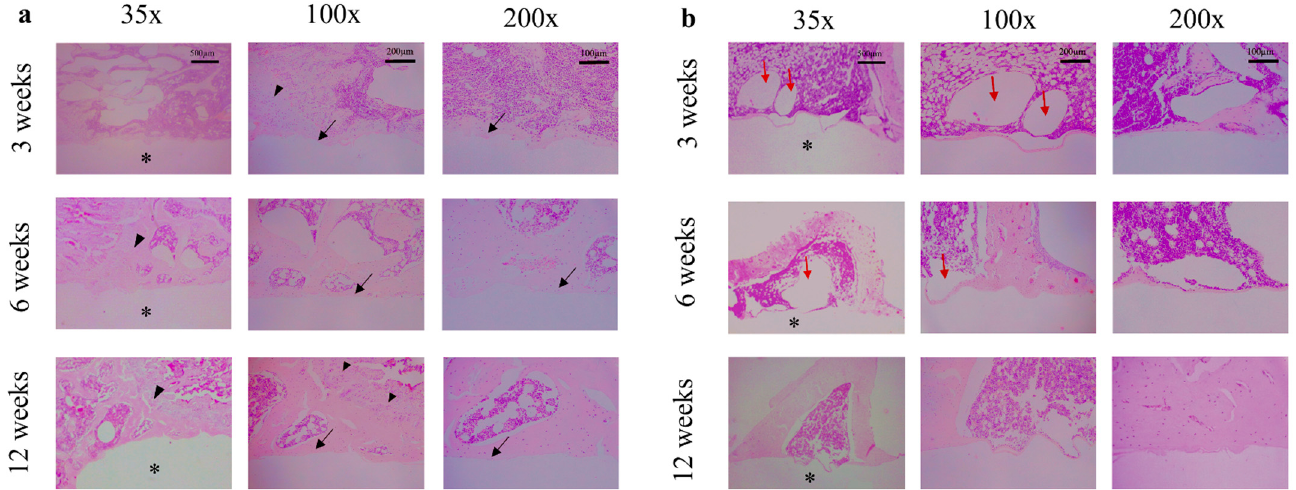
Figure 6. Hematoxylin and Eosin staining of the tissue surrounding the magnesium rod in ( a ) distal femoral epiphysis, and ( b ) tibial diaphysis at 3, 6, and 12 weeks. The black arrows indicate newly formed bone around the implant surface. The asterisk represents the position of the magnesium rod, and the gas pockets marked as red arrows. The black arrowhead shows the chondrocyte of the epiphyseal plate (growth plate).